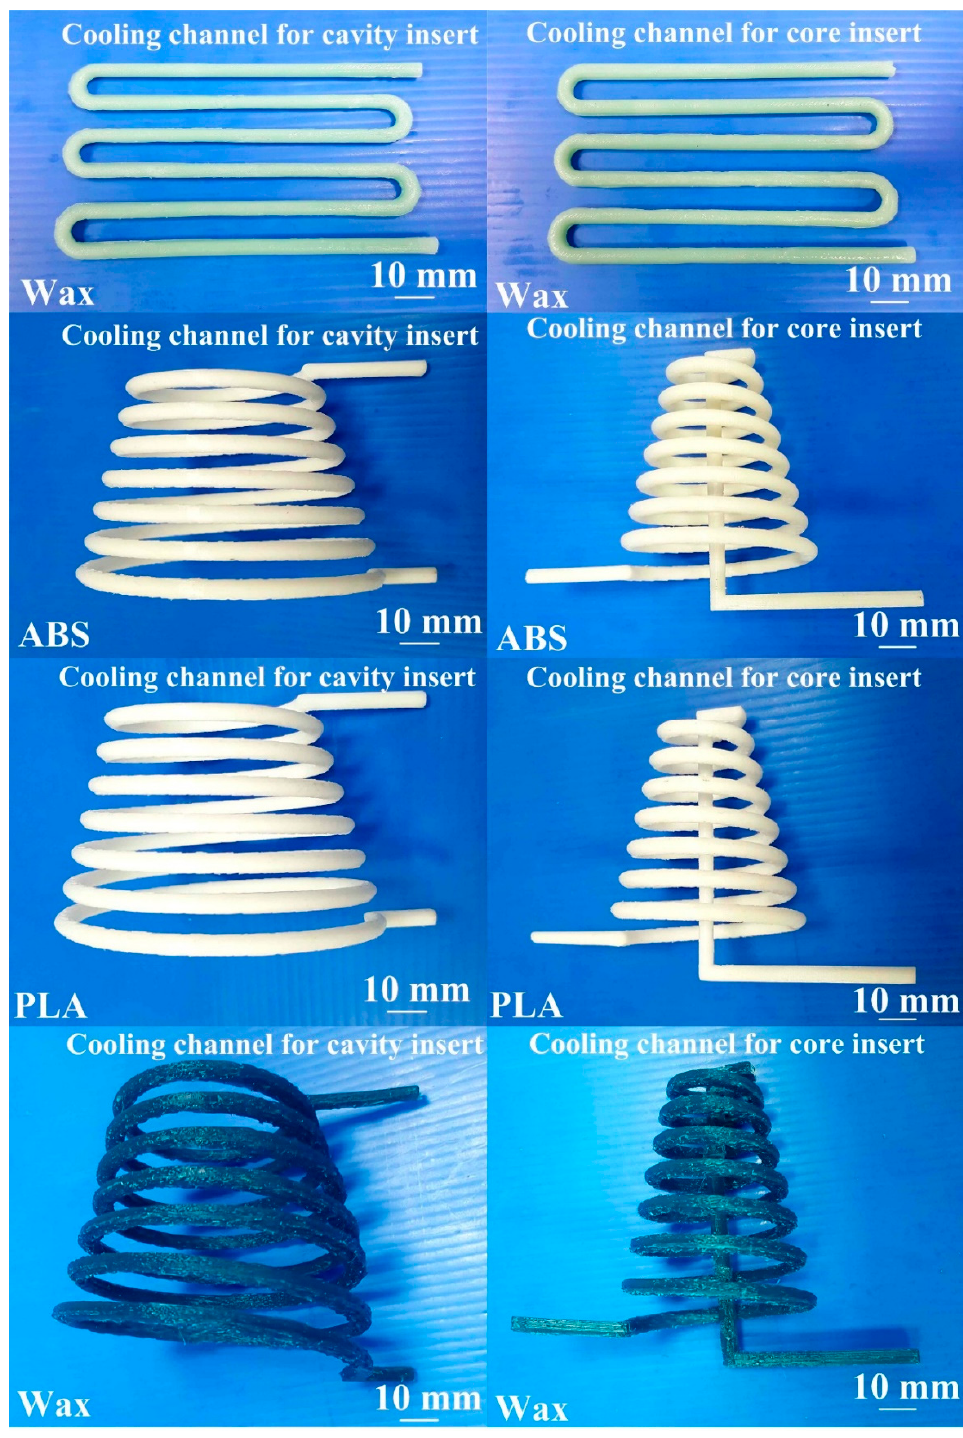
Figure 15. Photos of the conventional cooling channels and optimum CCCs.